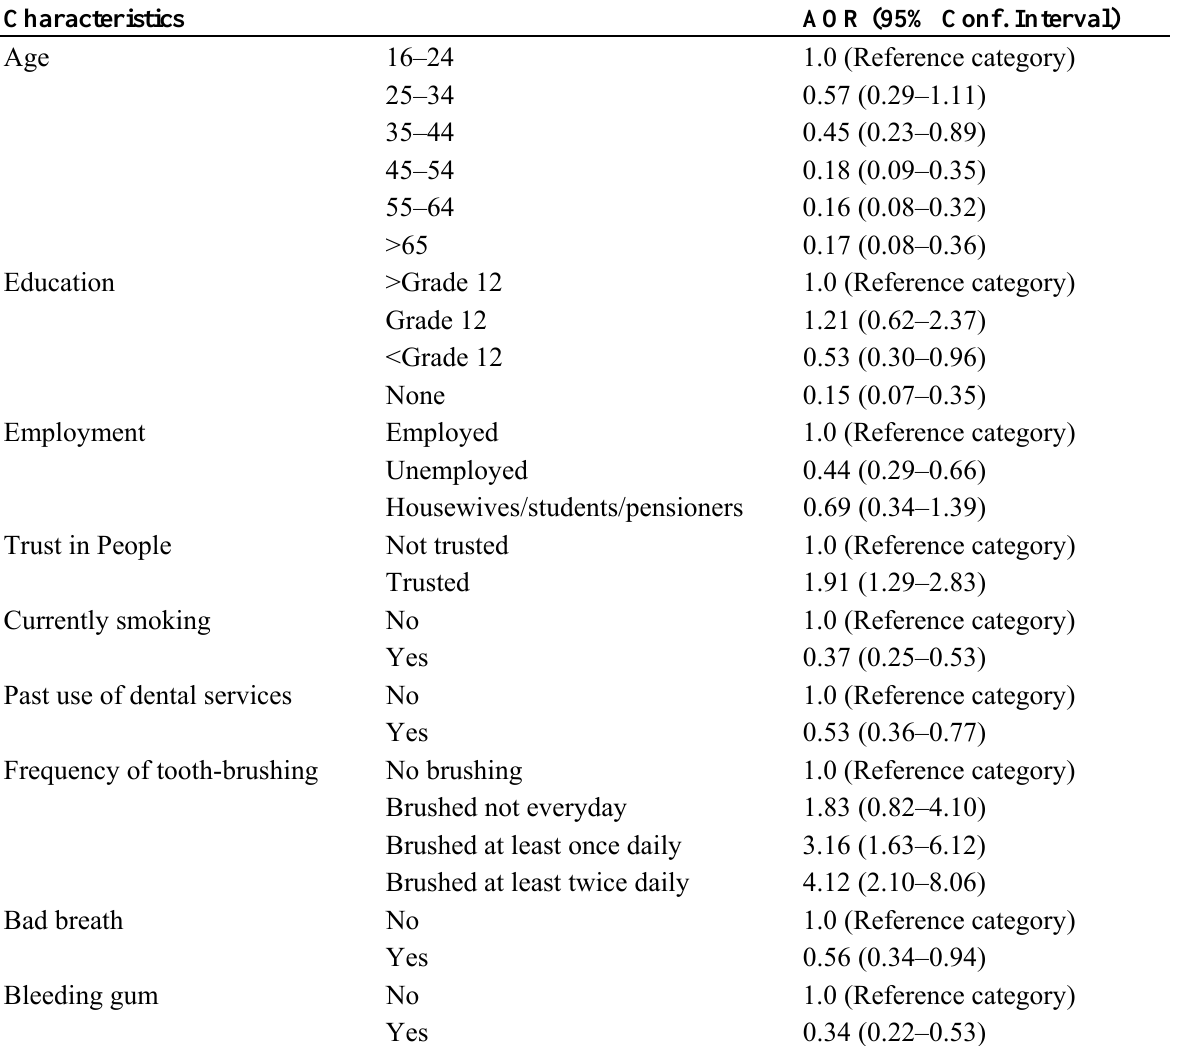
Table 4. Multilevel model of determinants of self-rated good oral health among men.